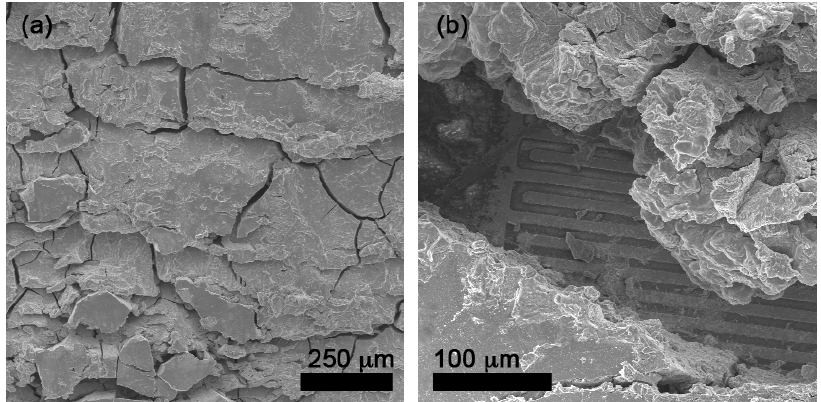
Figure 8. SEM images of tin dioxide gas sensor films deposited using the binder-paste method (Sensor C recipe). Panel a) presents a top view of the film and typical number and size of the film fractures. Panel b) presents a section of the film where the electrodes and the sensor support have been